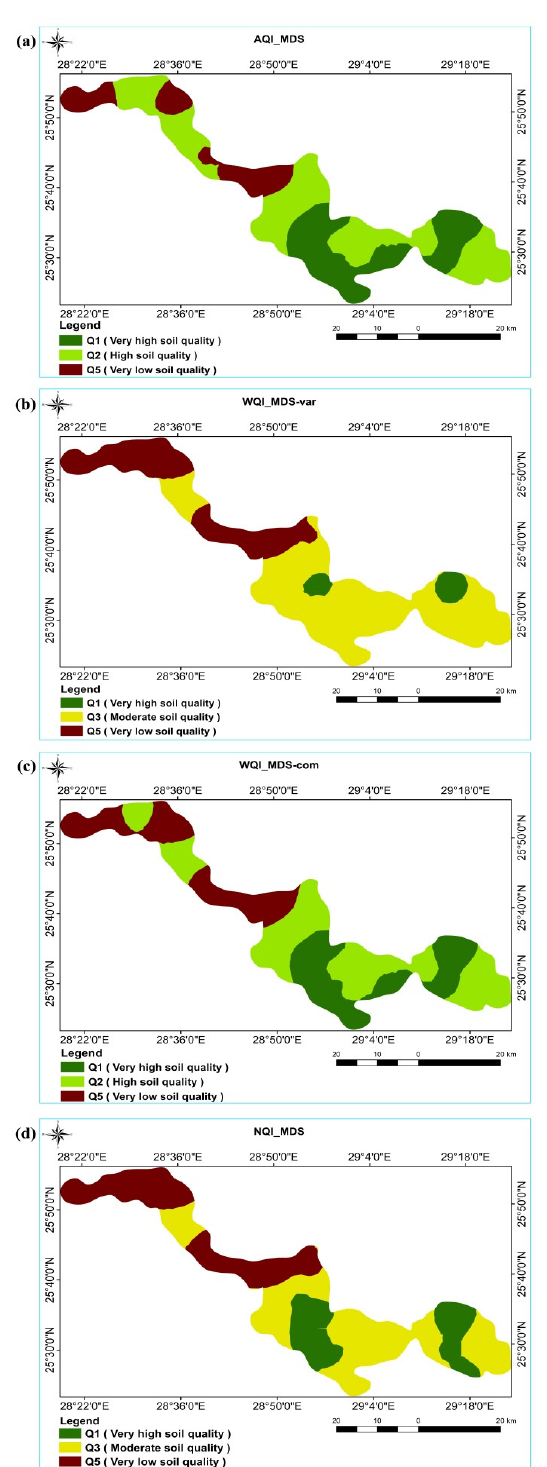
Figure 5. Soil quality grades based on minimum data set (MDS): ( a ) additive quality index (AQI); ( b ) weighted quality index-variation of PCA score (WQI-var); ( c ) weighted quality index- communality of the PCA score (WQI-com); and ( d ) Nemoro quality index (NQI).